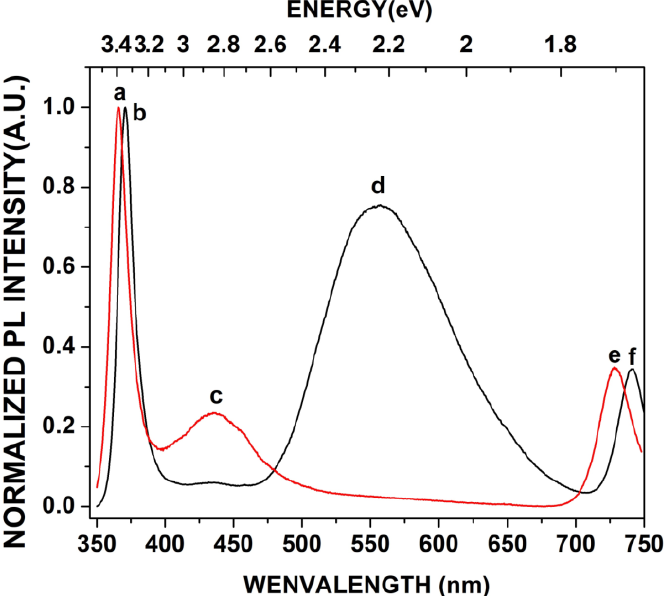
Figure 7. Photoluminescence spectra of the undoped GaN powders and the Mg-Zn co-doped GaN powders (a–f).